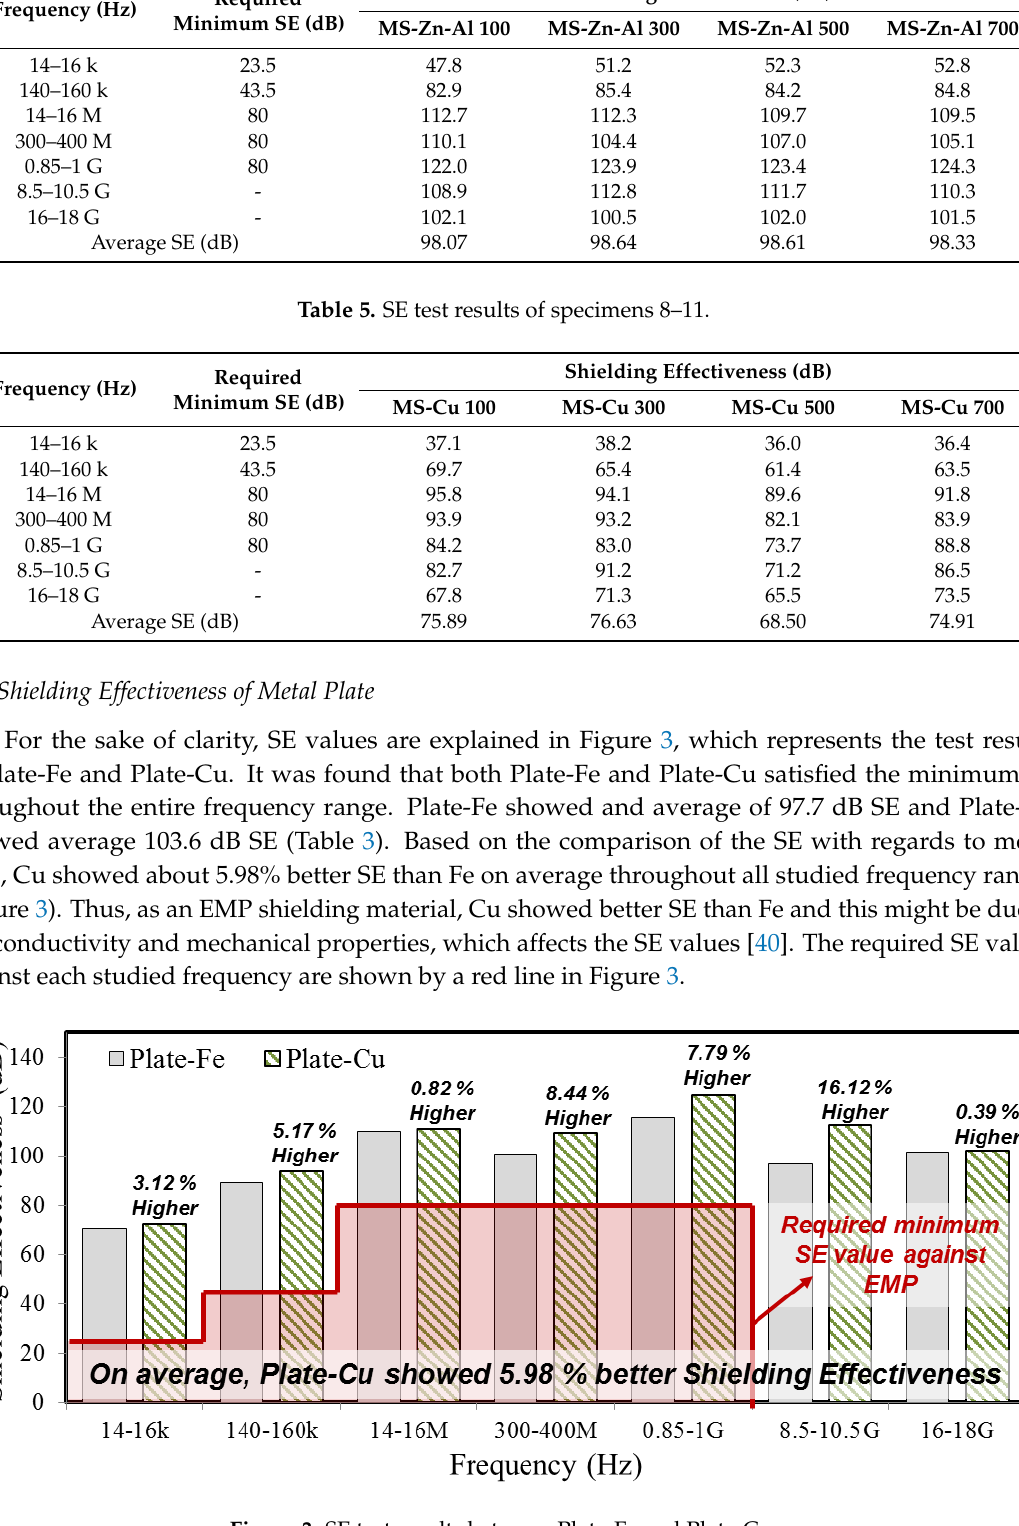
Figure 3. SE test results between Plate-Fe and Plate-Cu.